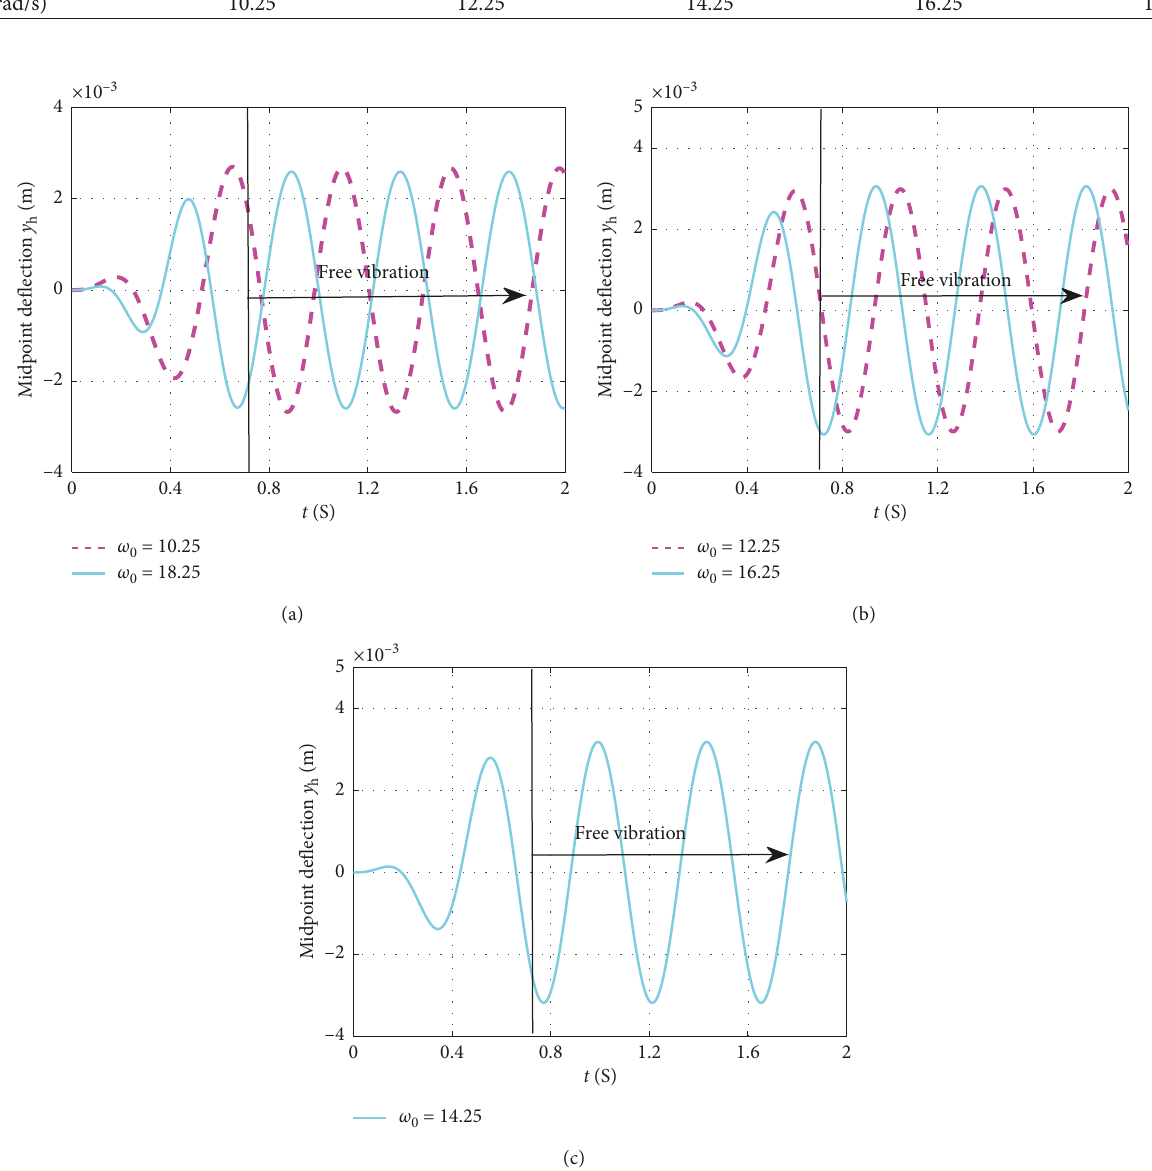
Figure 12: Time history curve of vertical displacement at bridge midspan.